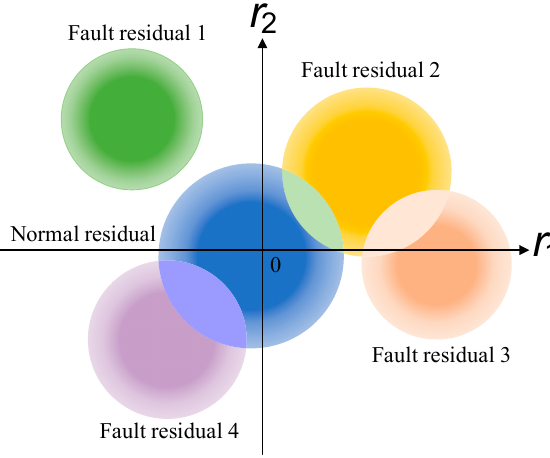
Figure 2. Residual distributions with measurement errors.